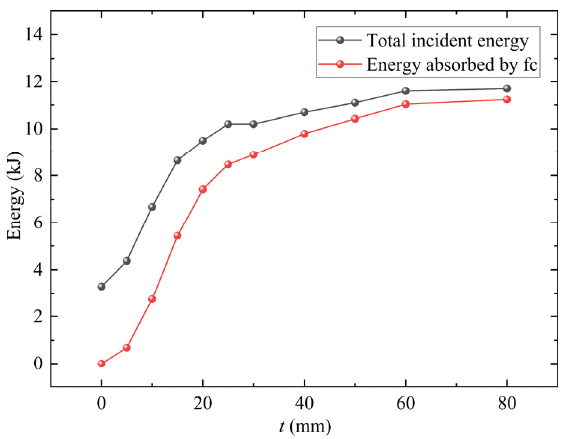
Figure 16. The variation of total incident energy and energy absorbed by foamed concrete with coating thickness.